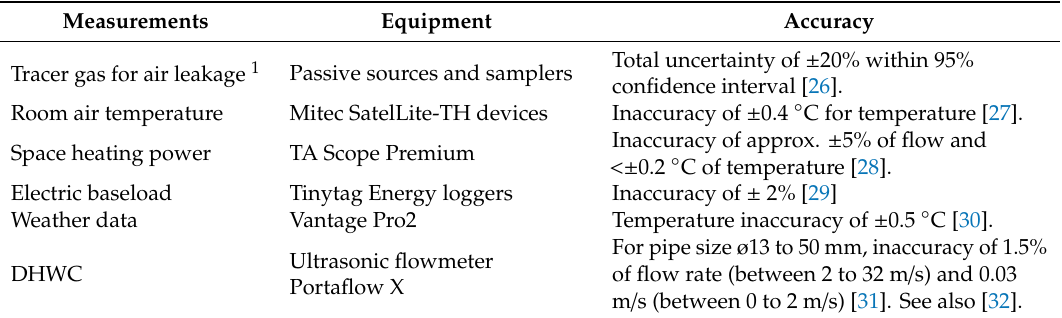
Table 4. Measurement equipment and